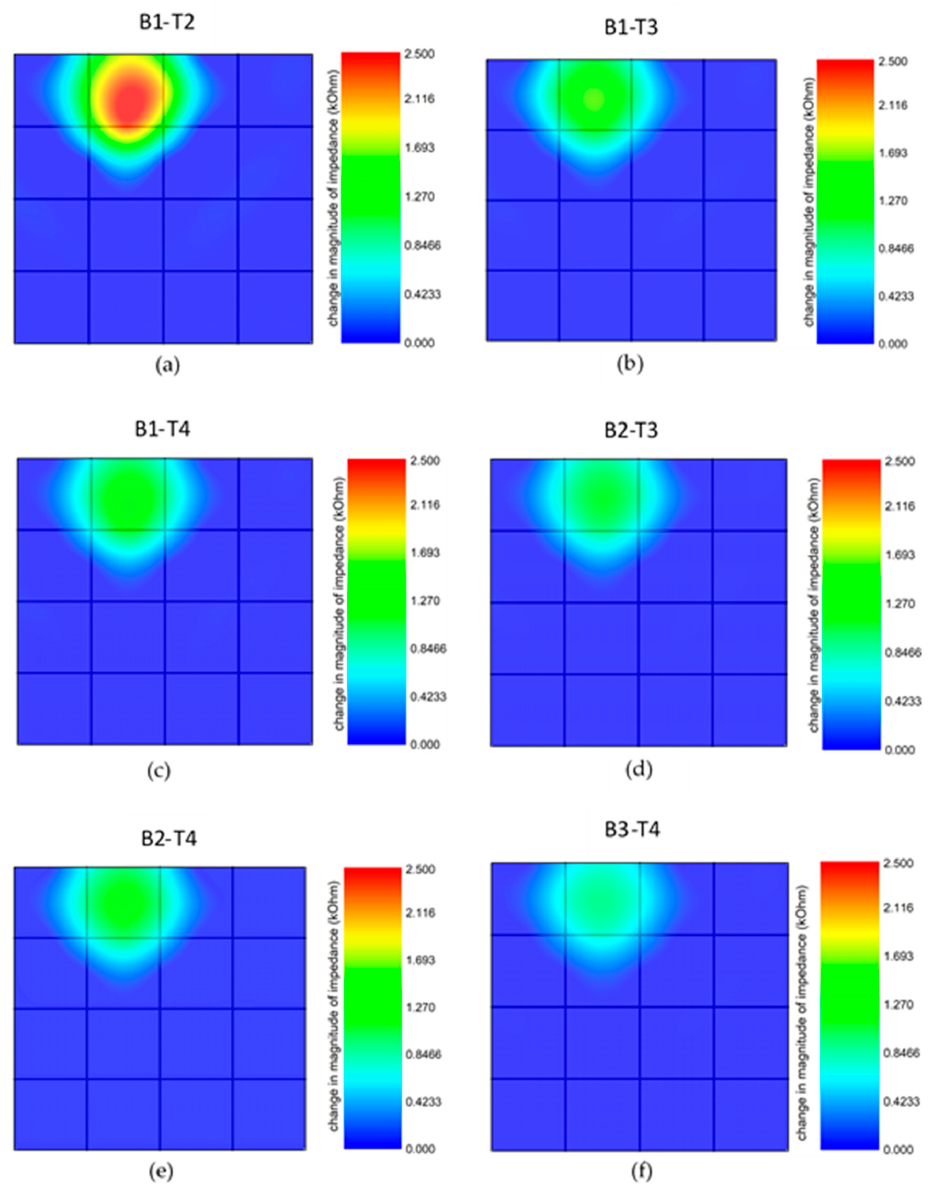
Figure 9. ( a – f ) The impedance distribution maps of the tactile sensor for the pressure applied on the specific region (labeled as 2 in Figure 4c) of the array obtained using different measurements.